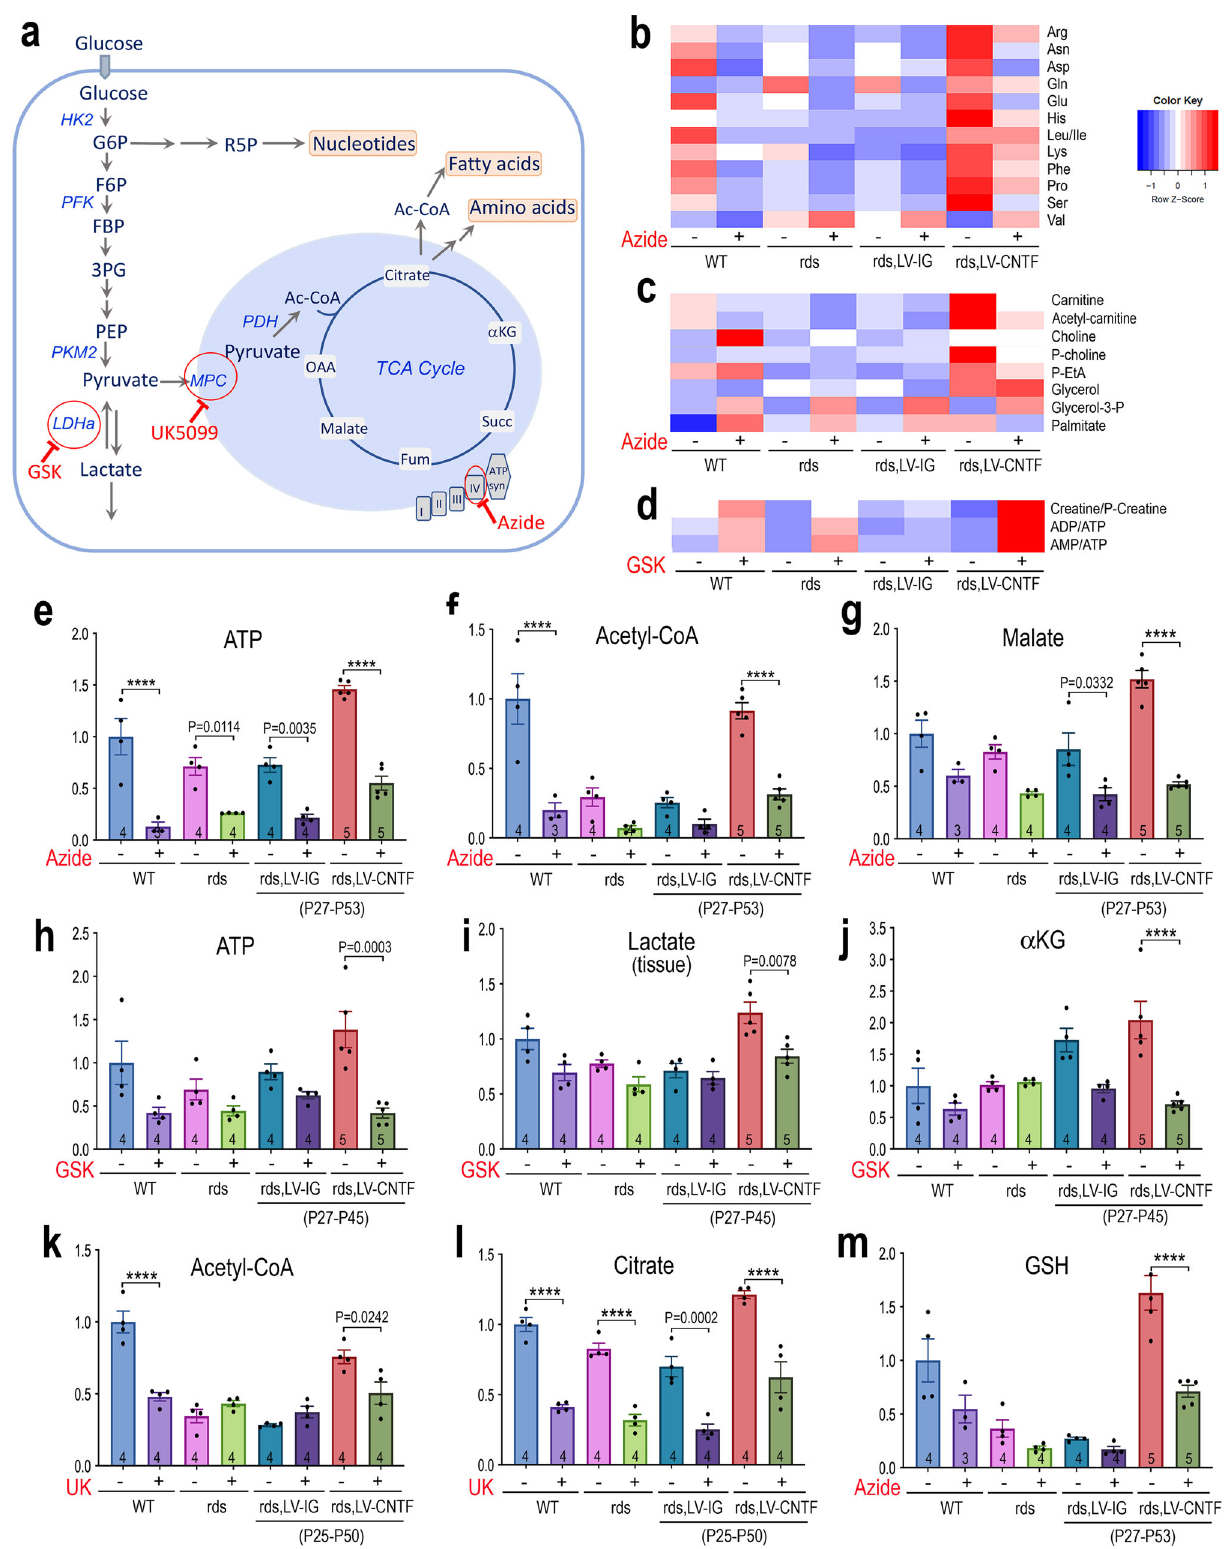
Fig. 7 | Contribution of glycolysis and mitochondrial activities to retinal metabolism and CNTF-induced metabolic changes. a Schematic illustration of theglycolyticpathwayandTCAcyclewithglucoseasafuel.Enzymaticstepsaffected by speci fi c inhibitors are indicated (red circle). b – d Metabolomics heatmaps show theeffectsofinhibitorsinWT,rds,andrdsretinastreatedwithLV-IGorLV-CNTFon metabolites. b amino acids. c fatty acid synthesis intermediates. d energy currency- related metabolites. e – m Bar graphs show the effects of inhibitors on the levels of